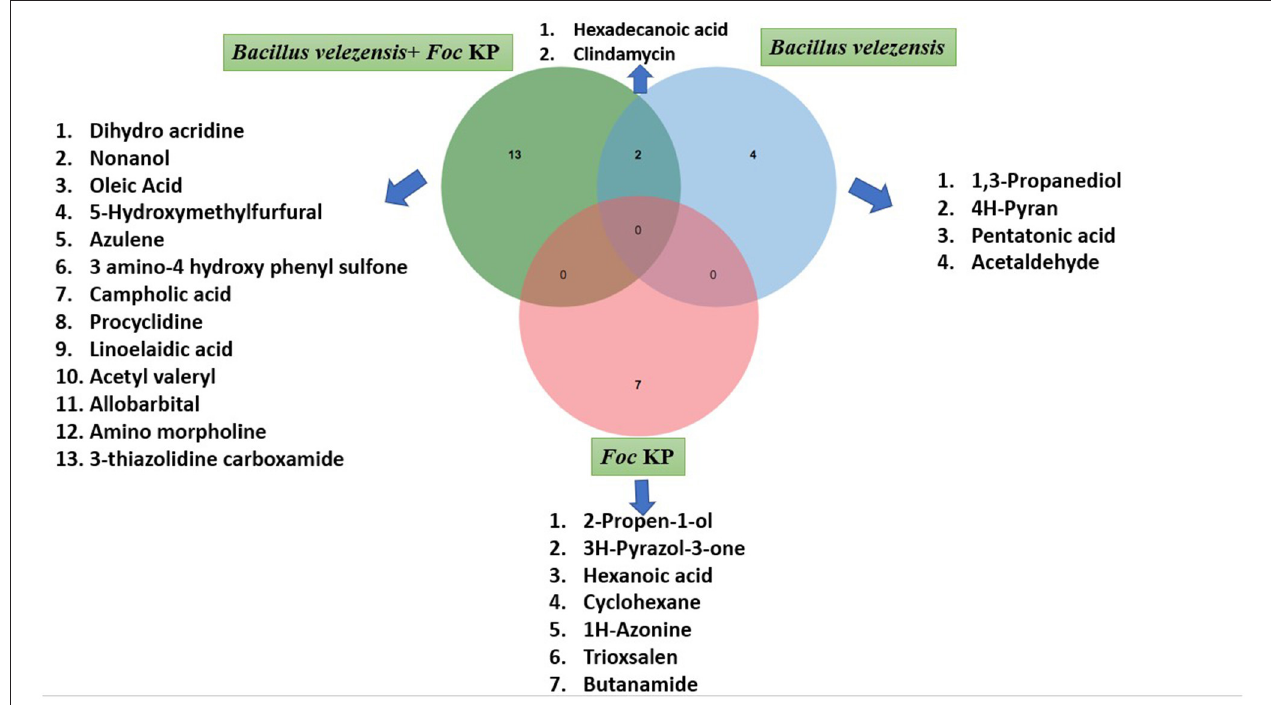
FIGURE 1 | Comparative distribution of VOCs/NVOCs produced by B. velezensis YEBBR6, B. velezensis YEBBR6 + Foc KP, and + Foc KP alone.